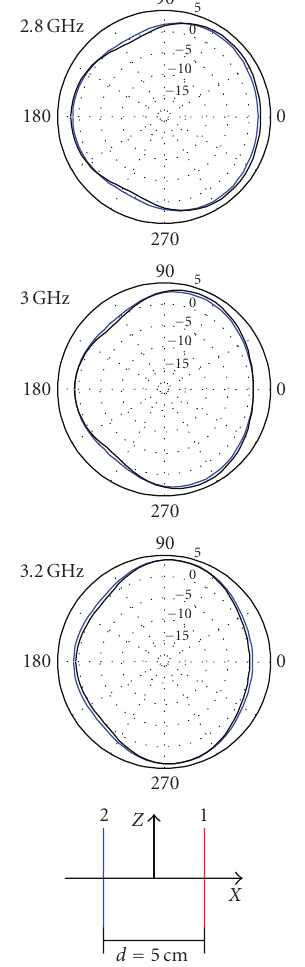
Figure 3: Thin dipoles ( d = 50 mm): simulated expected radiation pattern (black line) and point source approximation (blue